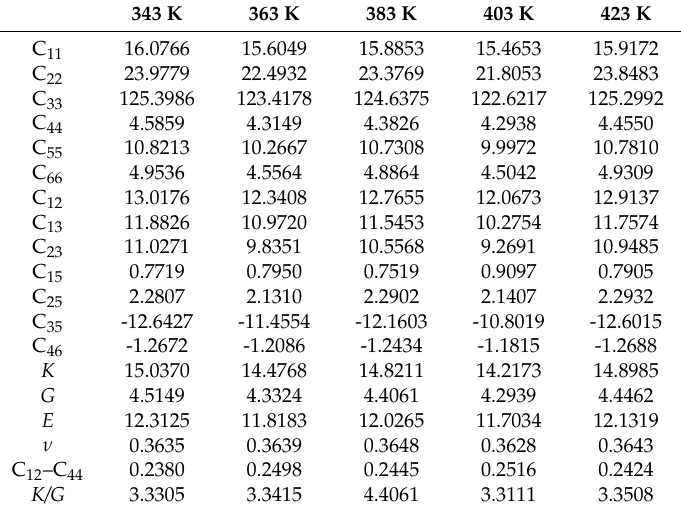
Mechanical parameters (GPa) of the crystalline regions of meta-aramid fibers at different